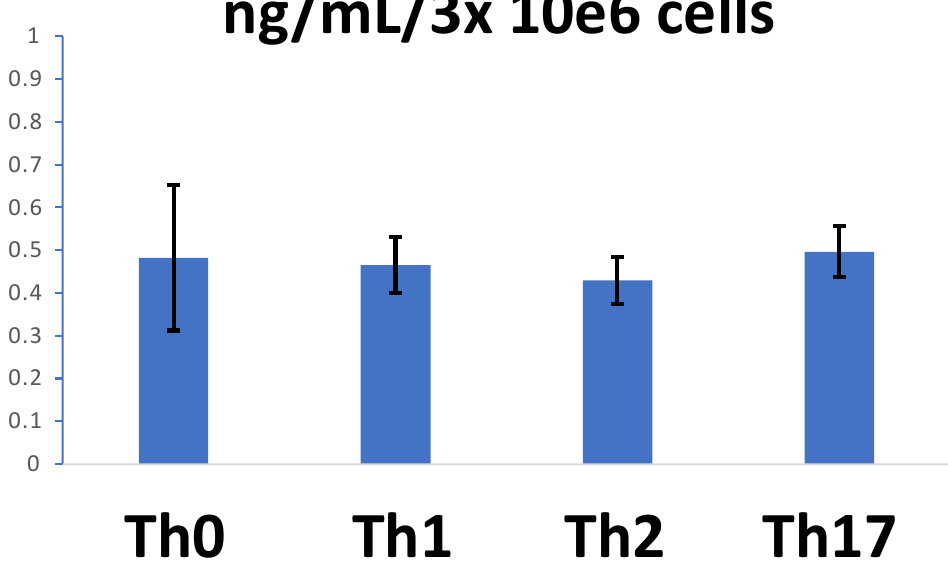
Figure 7: Levels of sCD26 in secretomes of T-cells cultured 3-day for polarization.